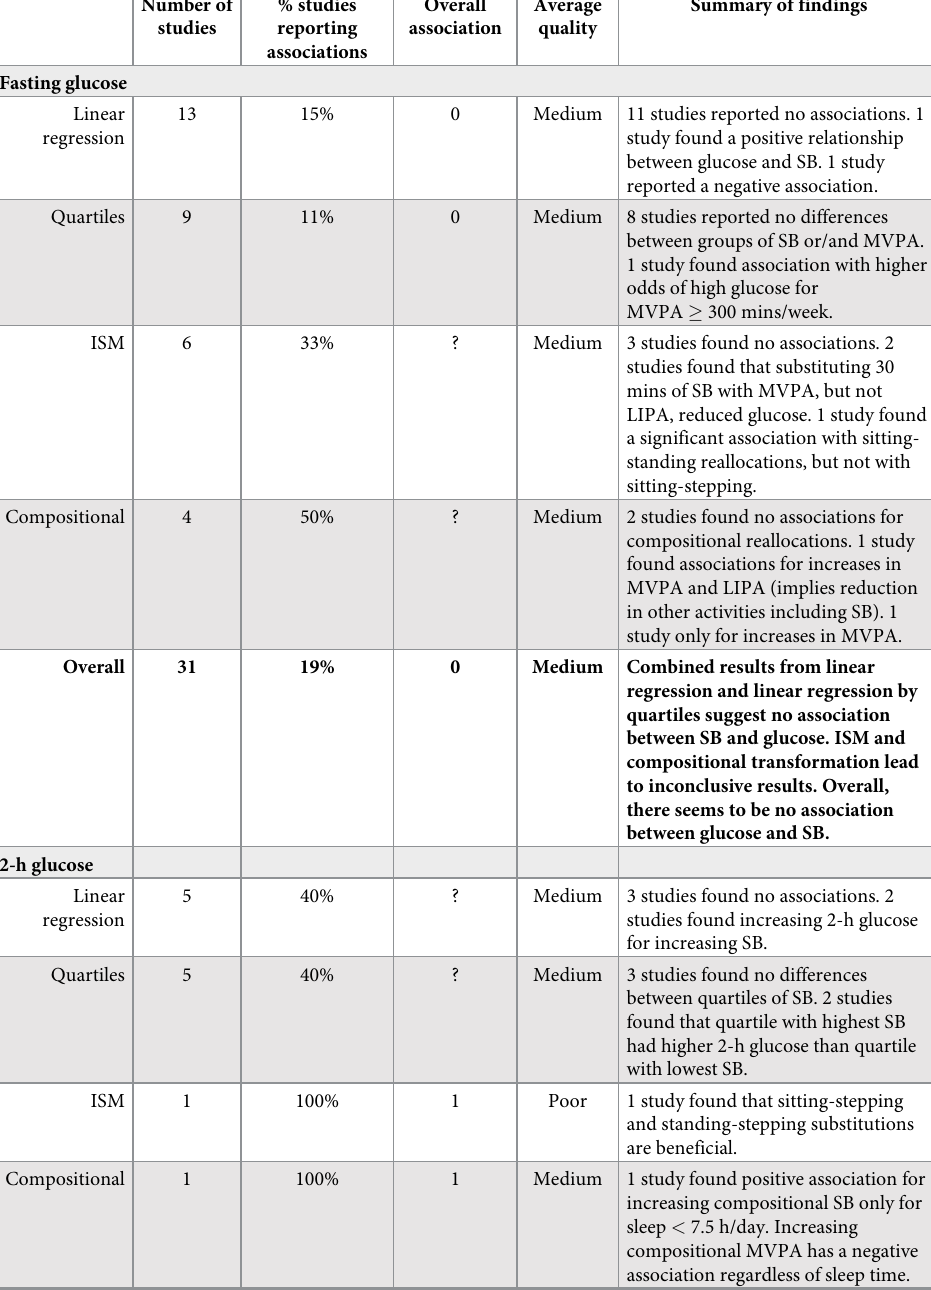
Table 3. Summary of findings table. Summarising the results from the included studies stratified by biomarker and analytical method. For the overall association, 1 means association found,? is inconclusive, 0 is no